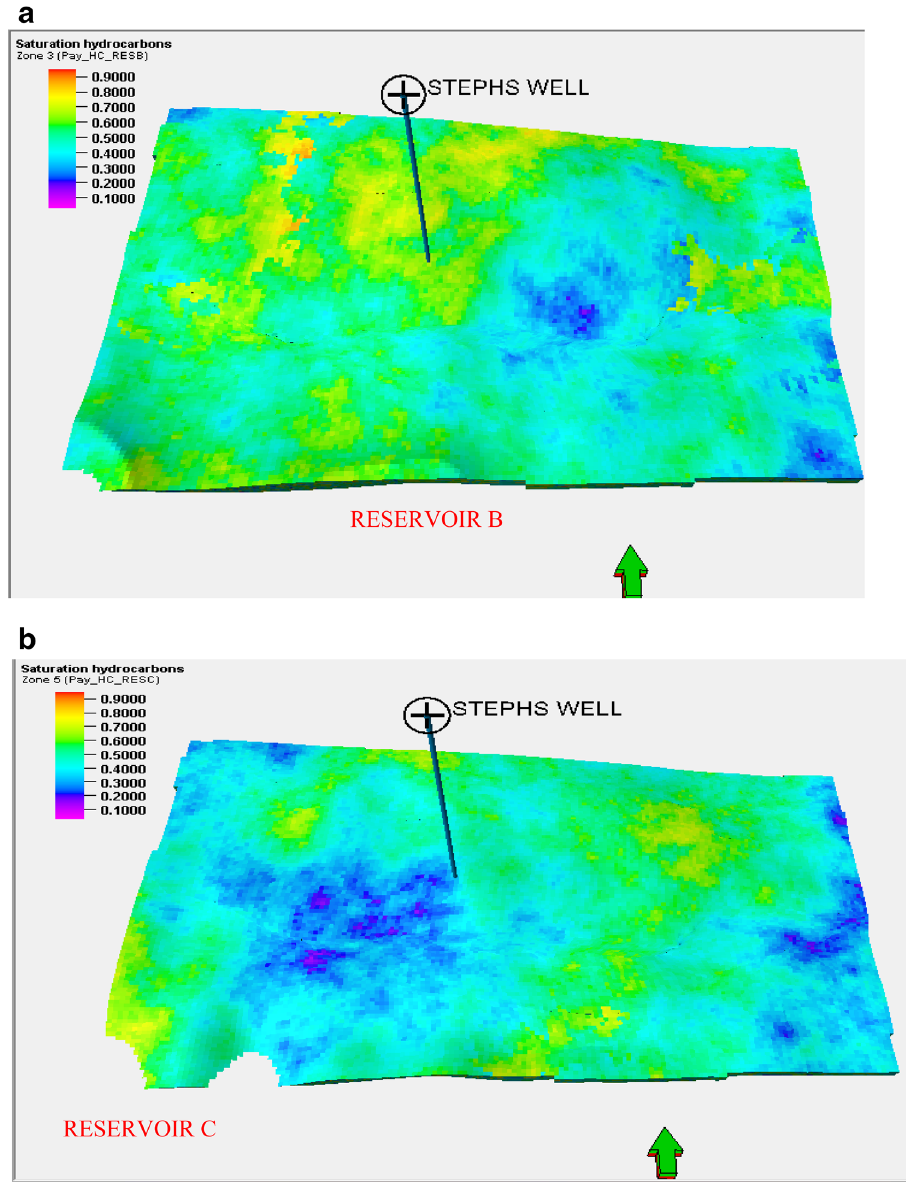
Fig. 11 a Hydrocarbon satura- tion model for reservoir B. b Hydrocarbon saturation model for reservoir